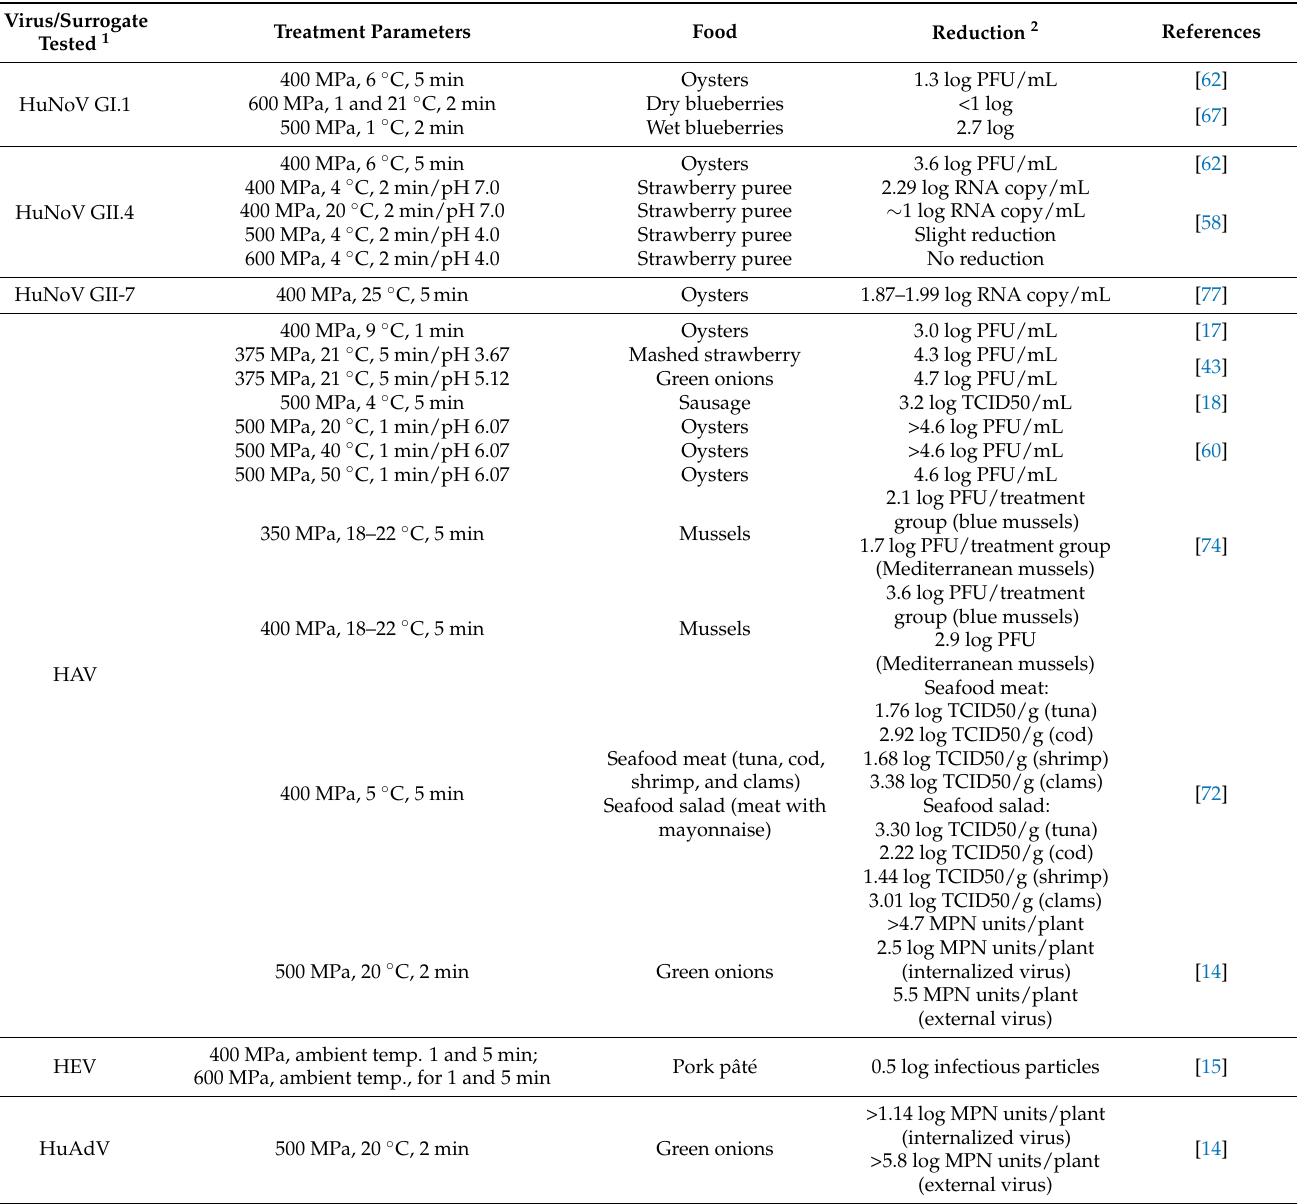
Table 3. Inactivation of foodborne viruses/surrogates during HPP treatments in various